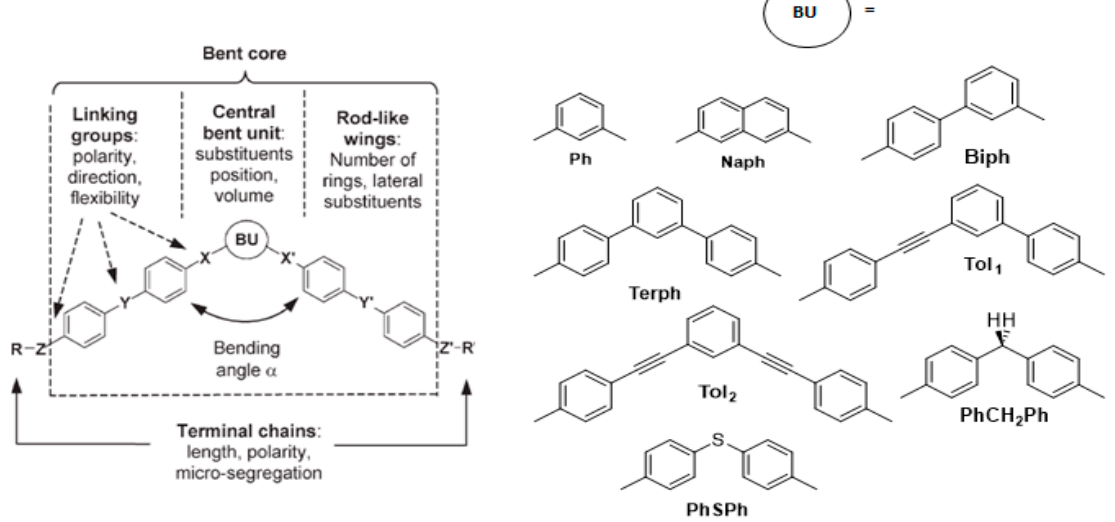
Figure 3. The general structure of bent-core mesogens and some central units [67].